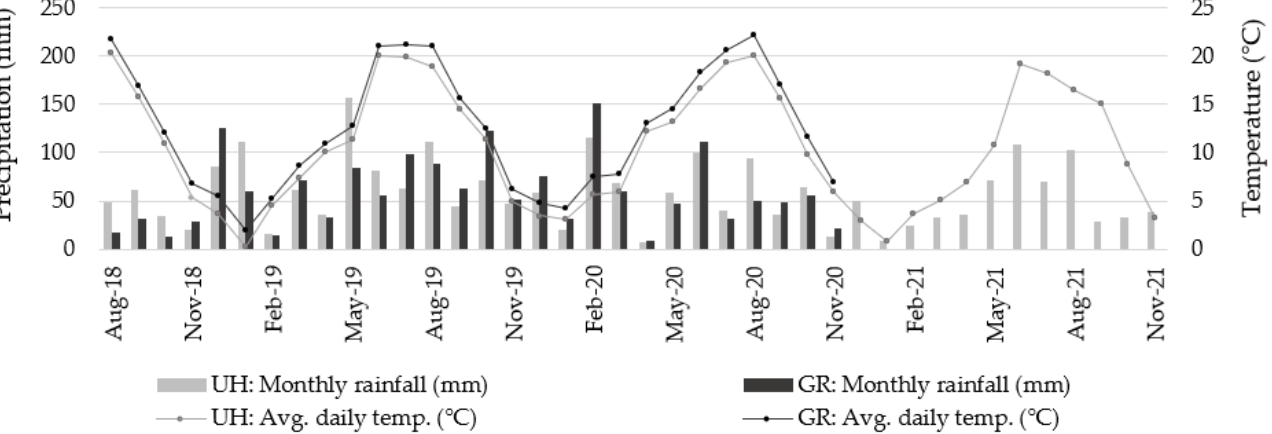
Figure 1. Monthly precipitation (mm) and temperature (°C) of the trial period between August 2018 and November 2021 at Grötzingen (GR) and the University of Hohenheim (UH). Source: www.wetter-bw.de, weather stations Grötzingen and Hohenheim.